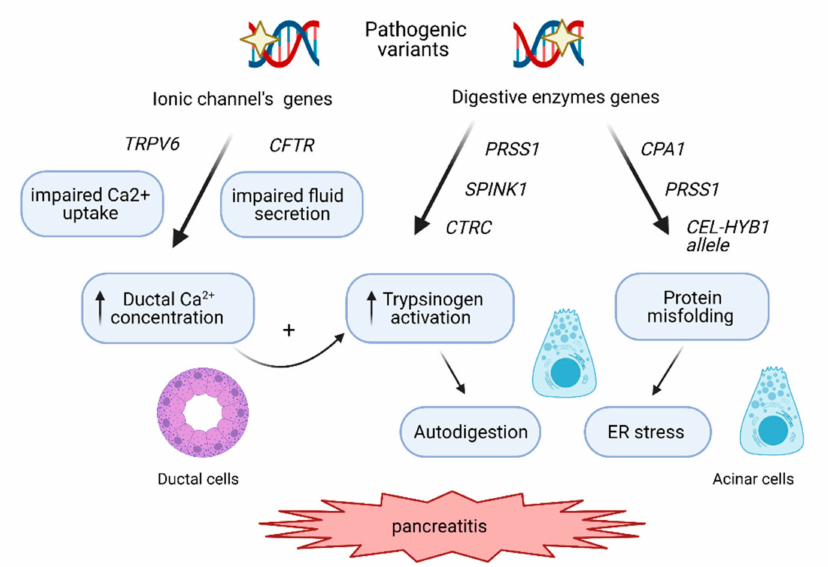
Figure 1. The molecular pathways involved in CP development. The genetic risk in CP is mediated mainly by the trypsin-dependent pathway, where pathogenic variants in PRSS1 stimulate autoac- tivation of cationic trypsinogen within the acinar cells, leading to autodigestion of the pancreas. Pathogenic variants in SPINK1 and CTRC disrupt inhibition of cationic trypsinogen activation or its degradation respectively, also contributing to a higher level of trypsinogen activation. The variants in genes such as CFTR and TRPV6 impair ductal secretion and Ca 2+ uptake, respectively, leading to increased Ca 2+ concentration in the ductal fluid, which in turn stimulates (auto)activation of trypsinogen. The third mechanisms involve endoplasmic reticulum (ER) stress caused by genetic variants in CPA 1, PRSS1 and by CEL-HYB1 alleles, inducing misfolding of these digestive enzymes and leading to acinar cell damage and inflammatory